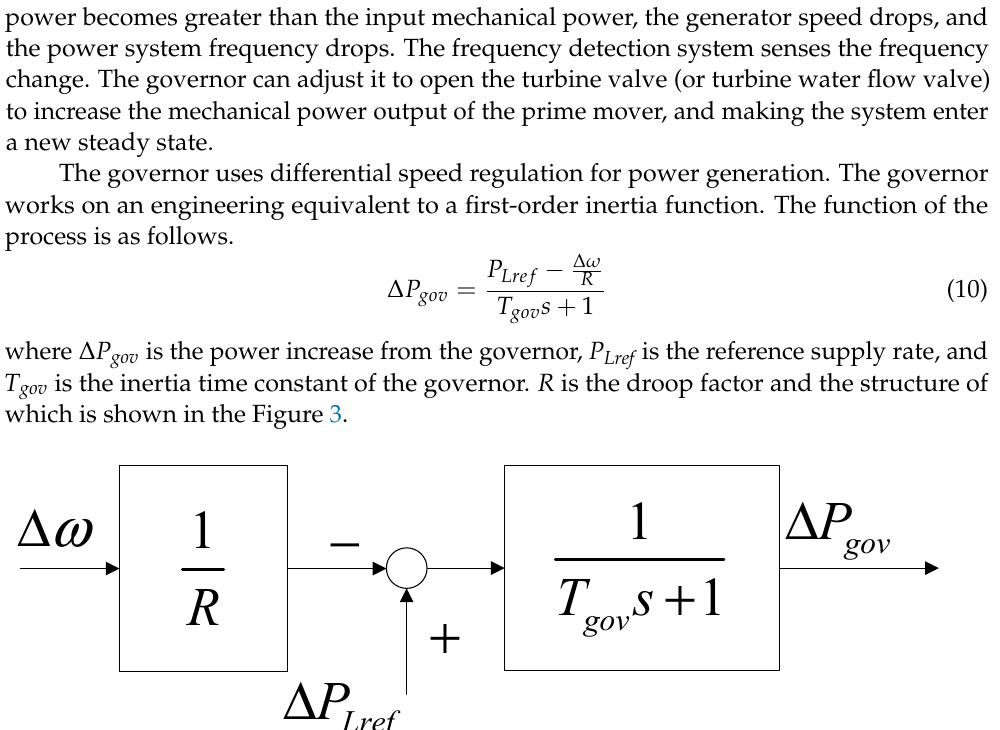
Figure 2. Model structure of frequency characteristic.